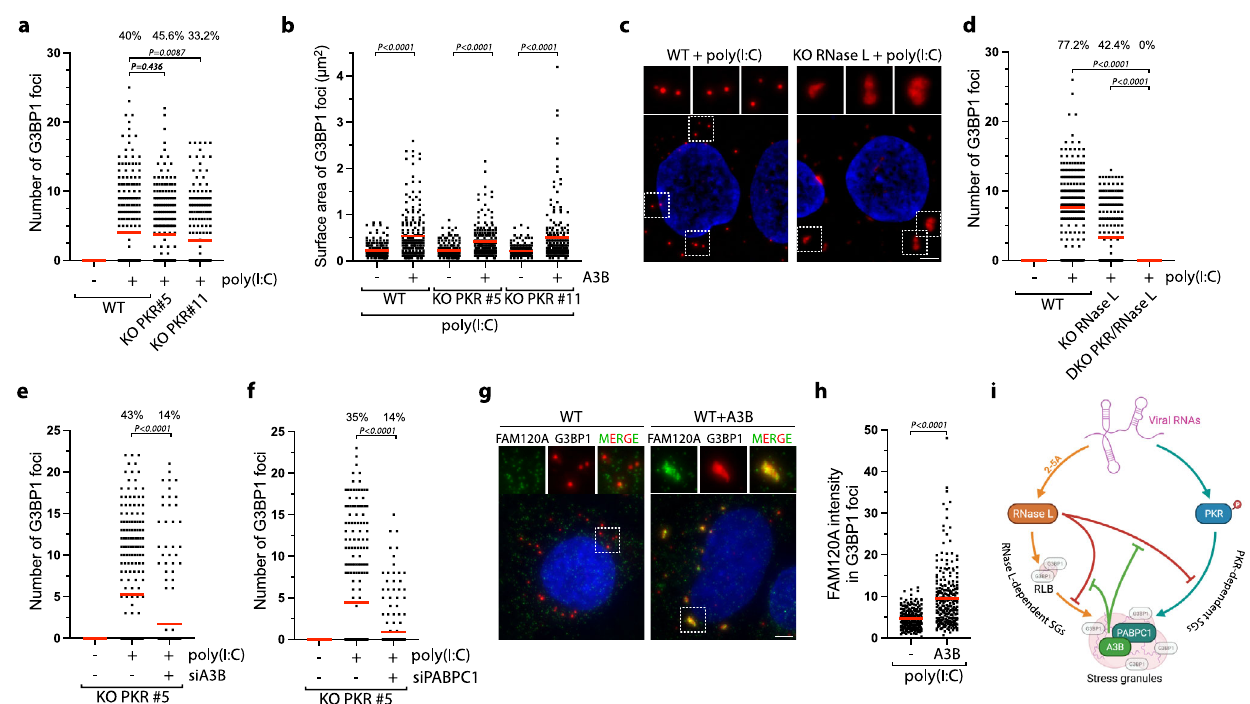
Fig. 7 | APOBEC3B induces unique RNase L-dependent stress granules. a U2OS WT and PKR KO cells were transfected with poly(I:C) (200ng/mL, 16h), and the number of G3BP1 foci by cell was quanti fi ed. Top; percentage of cells with G3BP1 foci. Red lines indicate the mean (Number of cells, n =250). P -values were calcu- lated with a two-tailed Welch t -test. b Quanti fi cation of G3BP1 foci area after transfection with poly(I:C) (200ng/mL, 16h) in U2OS-A3B-Flag WT and PKR-A3B- FlagKOcells.Redlinesindicatethemean(NumberofG3BP1foci,n=250). P -values were calculated with a two-tailed Welch t -test. c . Formation of G3BP1 foci after poly(I:C) (200ng/mL, 16h) transfection was monitored by immuno fl uorescence staining in U2OS-A3B-Flag WT and RNase L KO cells without DOX treatment. Scale bar: 5 μ m. d U2OS-A3B-Flag WT, RNase L KO, PKR/RNase L DKO cells were trans- fected withpoly(I:C) (200ng/mL,16h),and the numberof G3BP1 foci in individual cellswerequanti fi edwithoutDOXtreatment.Redlinesindicatethemean(Number